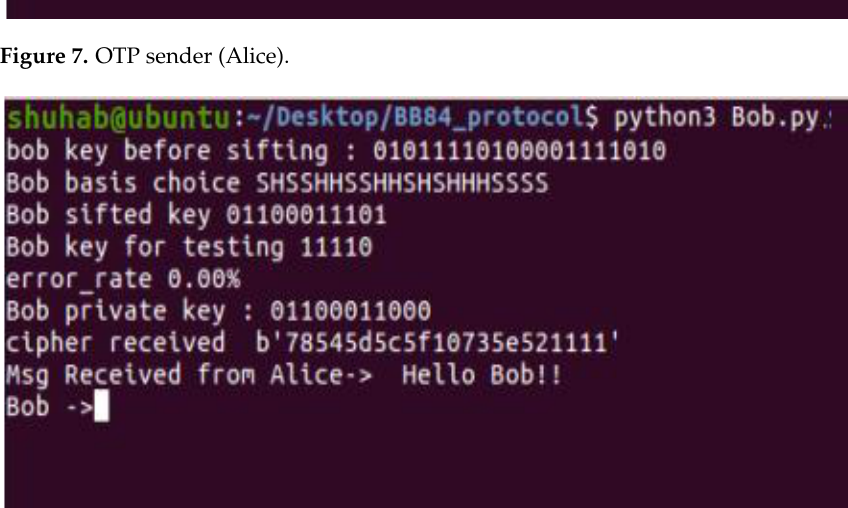
Figure 8. OTP receiver (Alice).